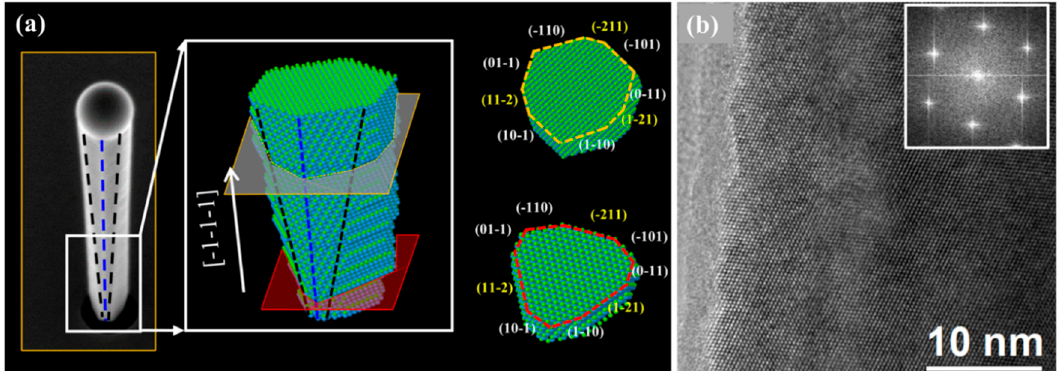
Figure 6. ( a ) High-magnification SEM image of a single NW and associated 3D model revealing the complex faceting composed of {110} and {112} planes. ( b ) High-resolution TEM image was taken along a [0 − 11] zone axis of a typical NW showing pure twin-free zinc blende crystal structure. Nano faceting is visible on the side of the NW. The inset shows the fast Fourier transform pattern, typical of untwinned zinc blende. Reproduced with permission from [47]; Copyright 2014, American Chemical